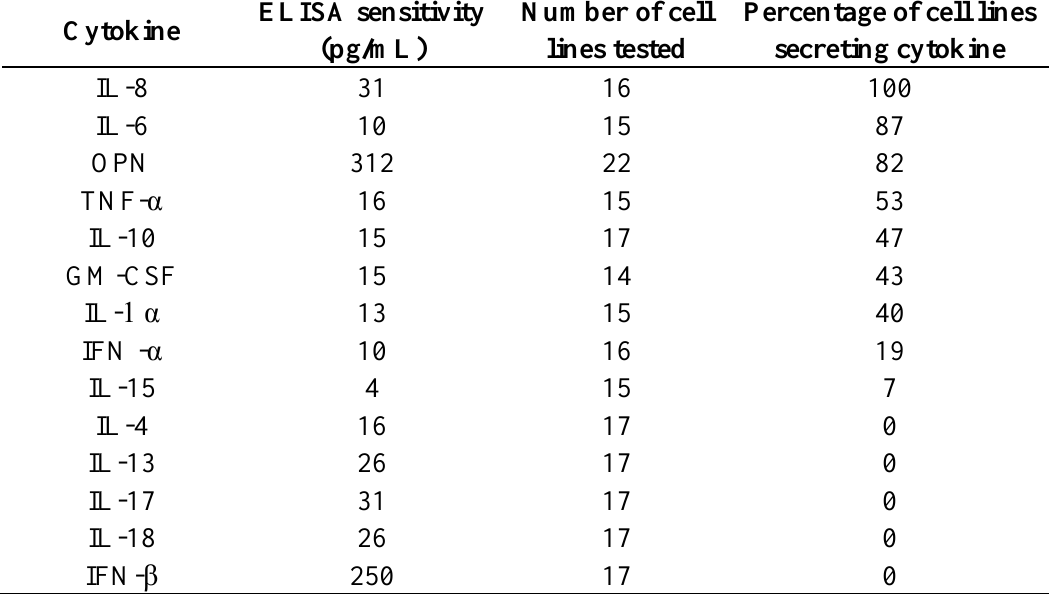
Table 1. Incidence of cytokines detected in the spent medium of human melanoma cell lines after seven days of